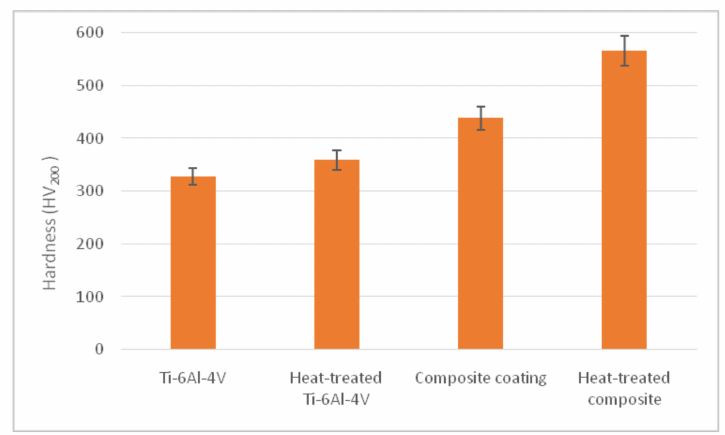
Figure 5. Average micro hardness